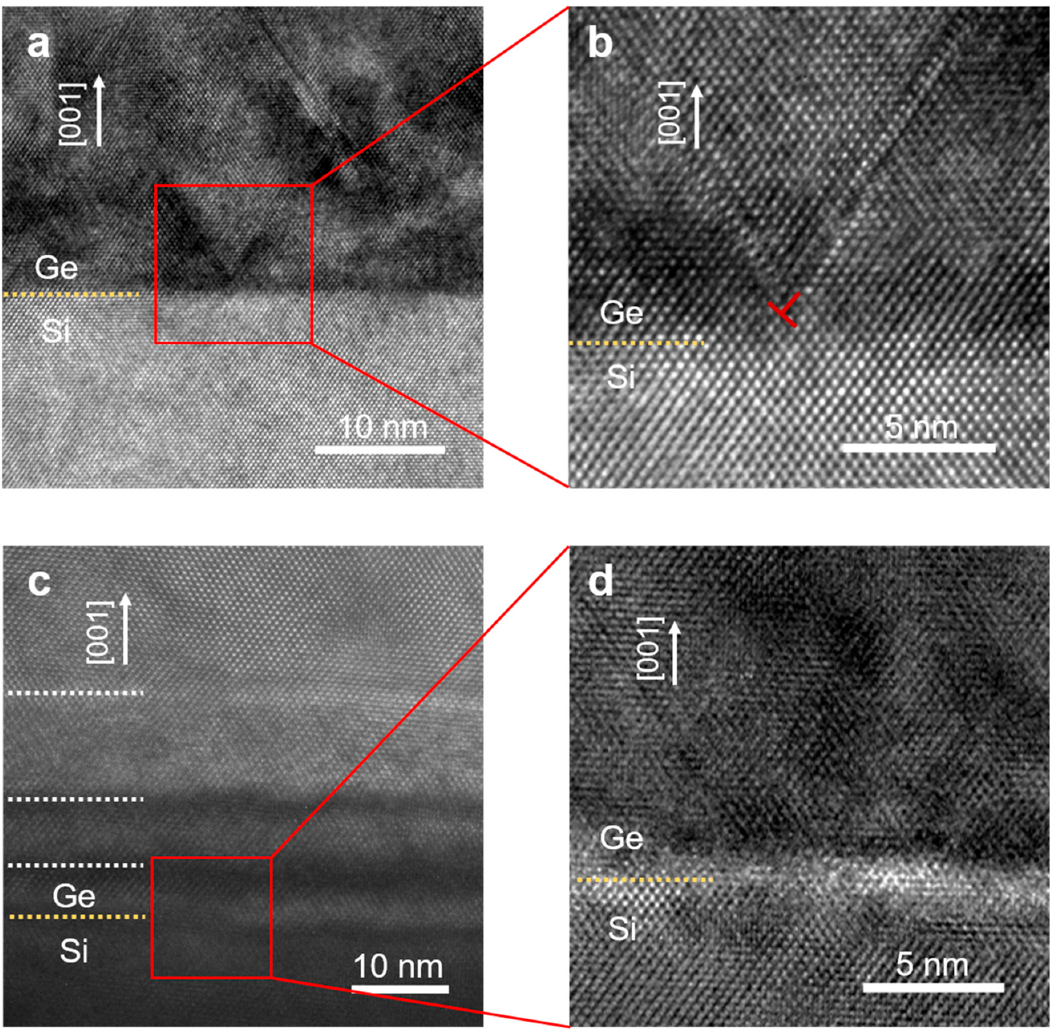
Figure 3. ( a ) Cross-sectional HRTEM image ([110]-zone) on an interface where strain is relaxed by dislocations; ( b ) zoom-in view of the red square marked in ( a ); ( c ) Cross-sectional HRTEM image ([110]-zone) an interface where strain is relaxed by the multiple-layered structures; ( d ) zoom-in view of the red square marked in ( c ). Yellow dotted lines highlight the interface of film and substrate. White dotted lines highlight the multiple-layered structures.